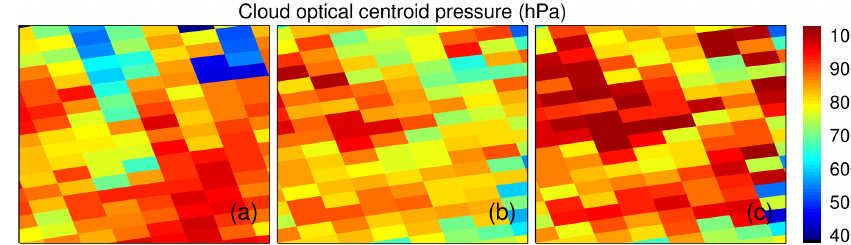
Figure 8. Similar to Fig. 7 but for cloud (optical centroid)